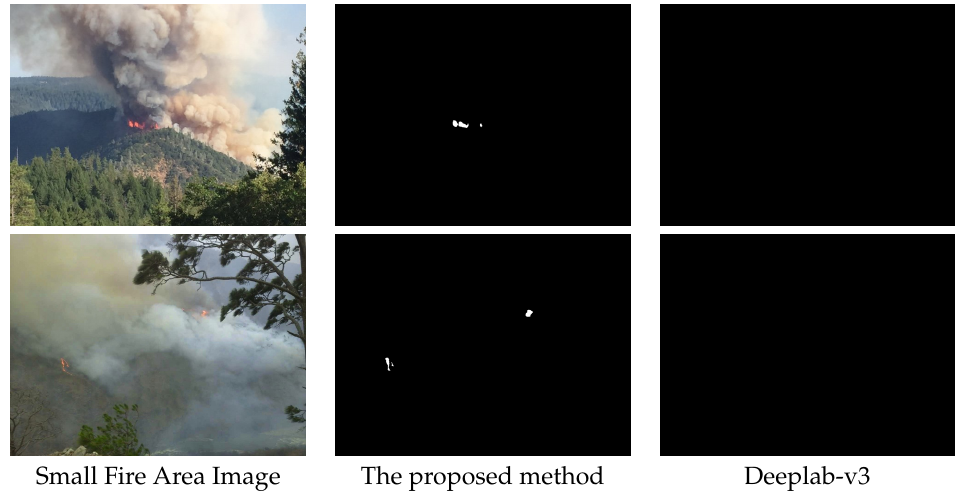
Figure 3. Examples of segmentation of small regions of fire in images covering large areas of terrain.